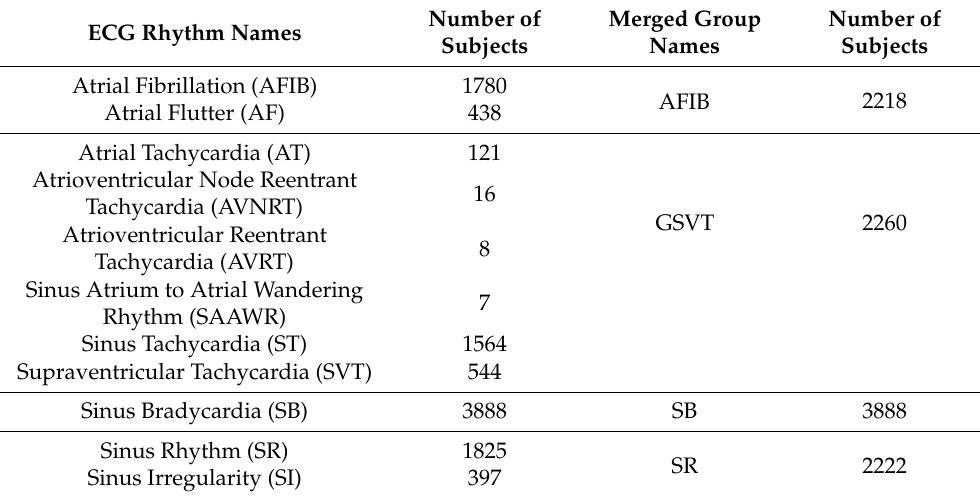
Table 1. Information on the 11 ECG rhythms and the four merged groups.